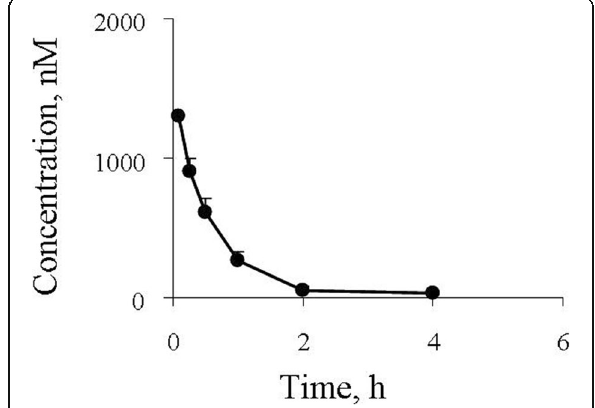
Fig. 3 Plasma concentration-time curves of bromophenol- thiosemicarbazone hybrid after intravenous administration of 2